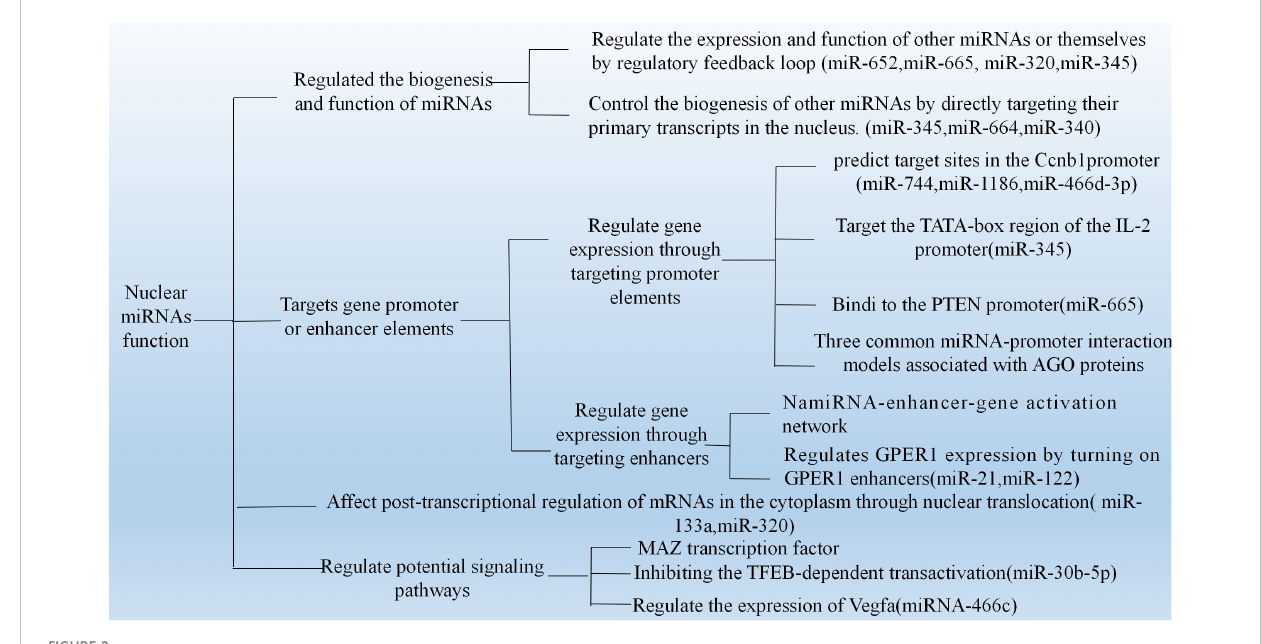
FIGURE 2 The mechanism of nuclear miRNAs which have been published. (1) The strong modulatory feedback loop between E2F1-3 and miR-20a. (2) Nuclear miRNAs target gene promoter or enhancer elements. (3) Participation of TFs for nuclear miRNA function. (4) Interact with the transcript to modulate Vegfa